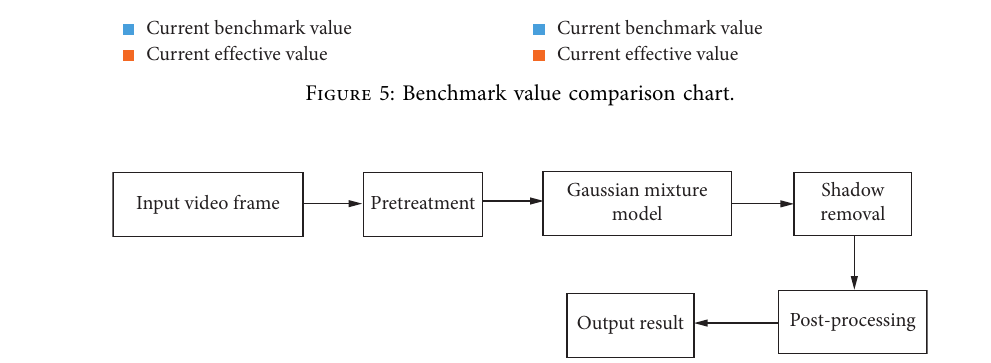
Figure 6: Flow chart of shadow removal algorithm based on Gaussian mixture model. Table 3: Object level detection rate.